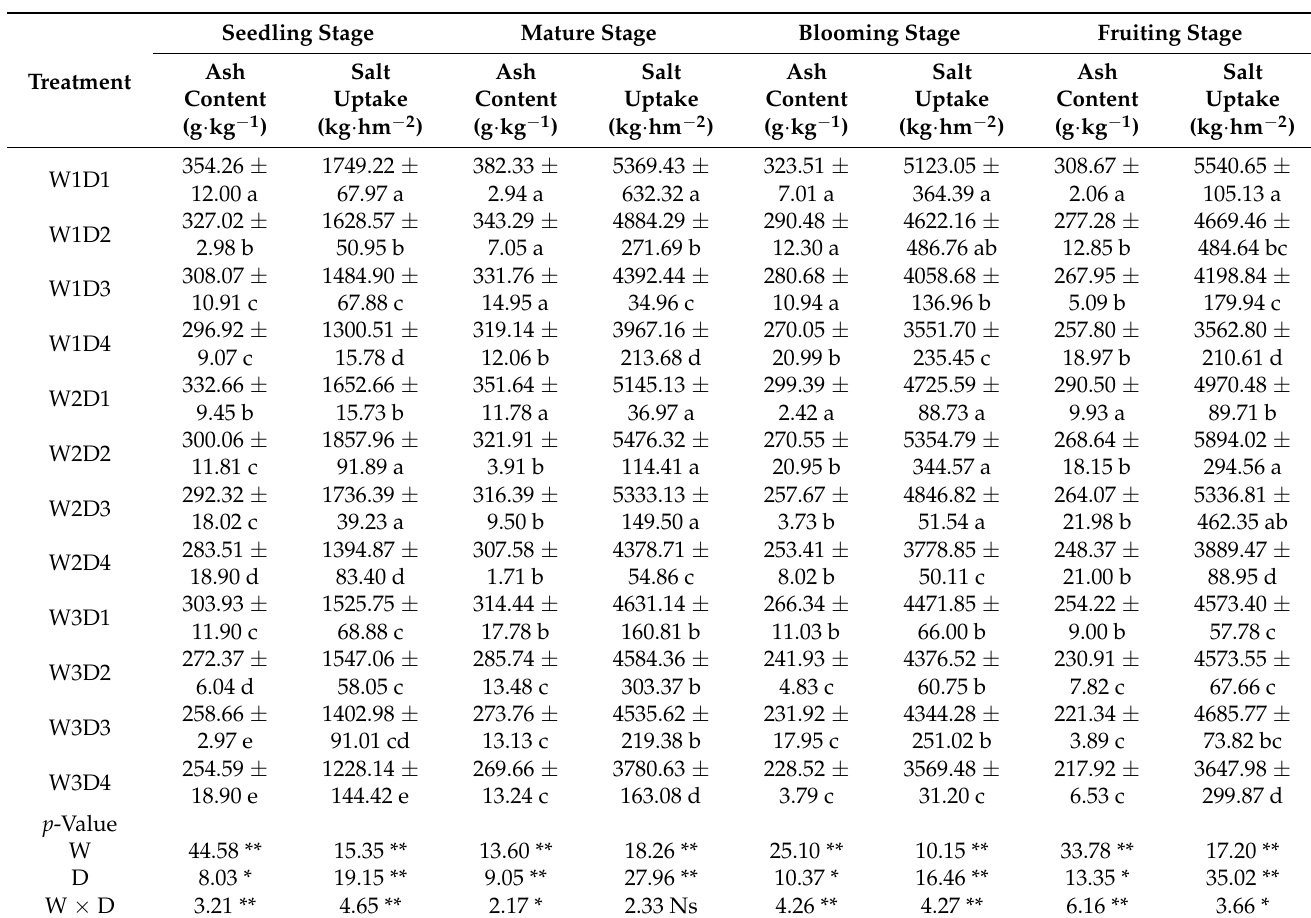
Table 5. Effect of different planting densities and irrigation volumes on the ash content and salt uptake of drip-irrigated Suaeda salsa